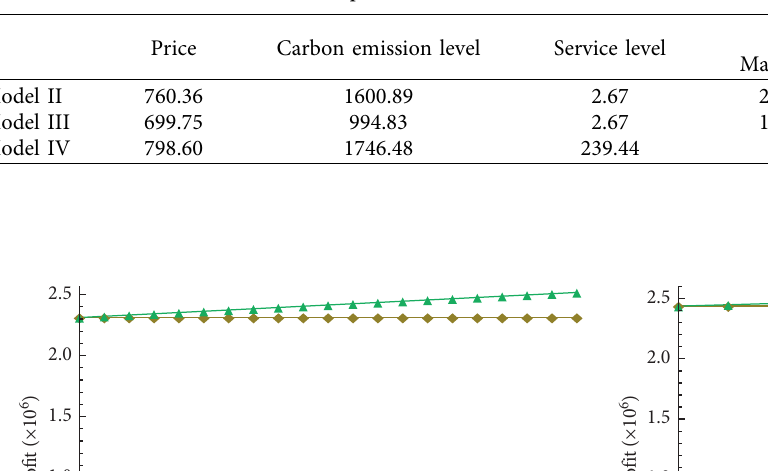
Table 2: Optimal decisions of different decision modes before coordination.